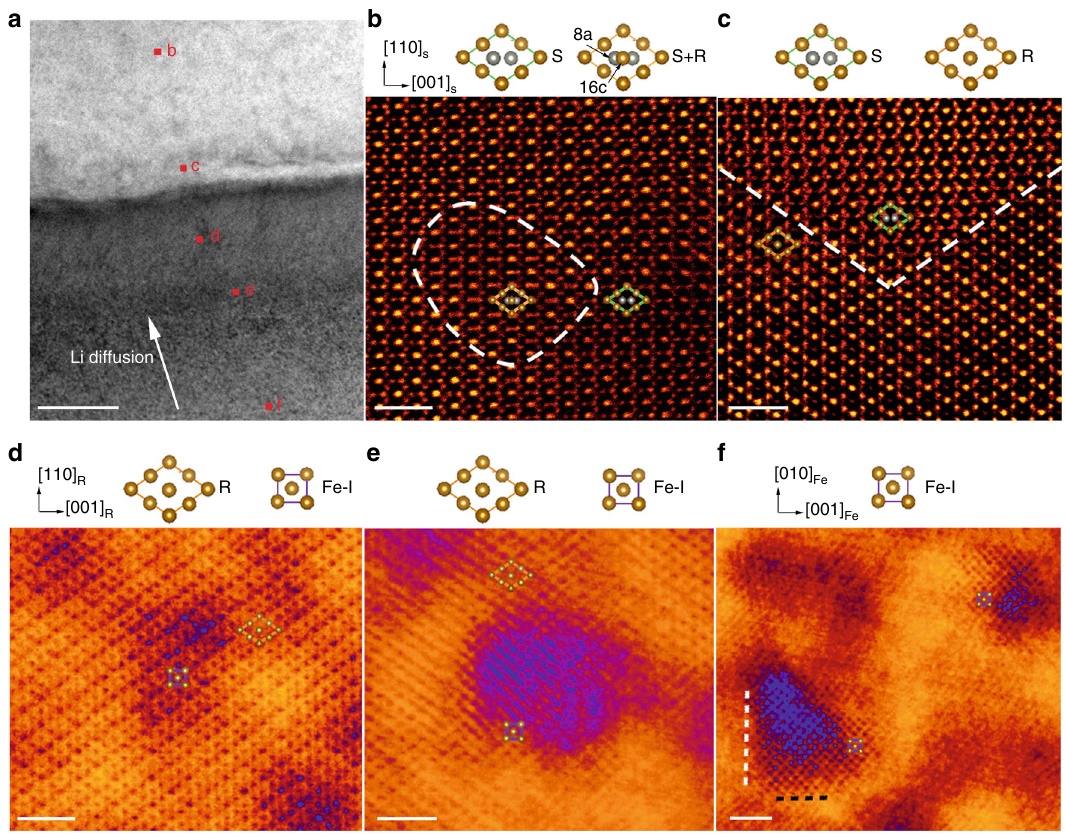
Fig. 3 Spatial correlation among the pristine, intermediate and fi nal phases in a partially lithiated Fe 3 O 4 single-crystal by atomic imaging. a Bright fi eld TEM image from a large area of the single crystal that was partially lithiated to a series of different states, shown by diffraction contrast. The direction of Li diffusion is indicated by the white arrow. Scale bar: 100 nm. b – f HAADF images taken at the local regions as labeled by the letters of b, c, d, e, f respectively, in ( a ). Scale bar: 1 nm. The spinel (S) and rocksalt-like Li x Fe 3 O 4 (R) phases are both projected along the [1 (cid:1) 10] direction. Dashed lines in ( b ) and ( c ) label the boundaries between S and the mixture of S and R, and that between S and R, respectively. The Fe-I nanograins are projected along the [100] direction, as marked by purple in ( e ) and ( f ). The interfaces between R and Fe-I, i.e., {001} Fe-I and {010} Fe-I , are marked by white and black dashed lines in ( f ), respectively. The atomic arrangements of Fe in S, R and Fe-I are shown on the top of each HAADF projected along the [100] direction, exactly the same as the projection detected by ED (Fig. 2). In the region f at the full lithiated state, only multiple Fe-I nanograins, aligned along the same orientation, were observed (Fig. 3f). The interfaces between Fe-I nanograins and ccp framework were marked by white and black dashed lines in Fig. 3f, corresponding to {001} Fe-I // {001} ccp and {010} Fe-I // {110} ccp , respectively. Moreover, structural transformation from FeO to Fe-I, as given in Supplementary (cid:1) 10] FeO , Fig. 6, shows the orientation relationship of [100] Fe-I // [1 which is the same as that in Fig. 2. The interface planes were determined to be {010} Fe-I and {110} FeO . Therefore, in addition to